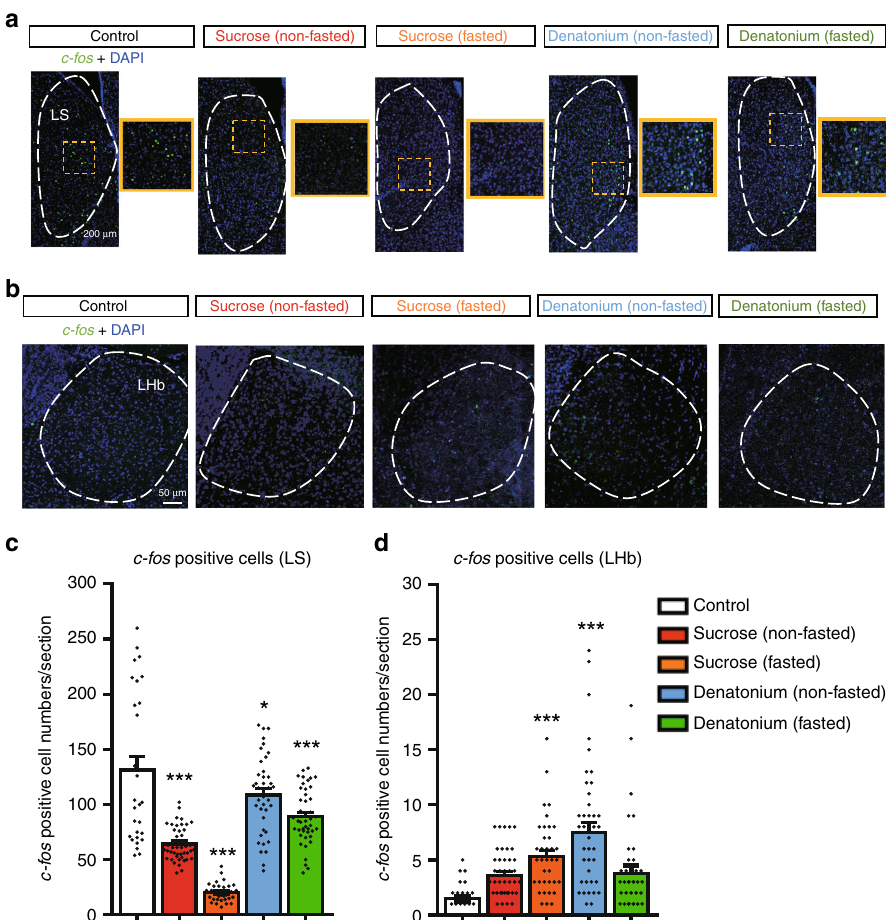
Fig. 8 Fasting differentially affects taste-induced c-fos expression in the LS and the LHb. a , b Representative images showing c-fos -positive cells in the LS ( a ) and in the LHb ( b ). c , d Quanti fi cation of c-fos- positive cells in the LS ( c ) and in the LHb ( d ). The mice were treated with sucrose or bitter taste under fed or fasted conditions. n = 3 – 5 mice per group and ~10 brain slices per mouse were analyzed. F = 51.25 and P = 4.9 × 10 – 8 in c , F = 11.1 and P = 0.0069 in d , one- way ANOVA with Dunnett ’ s post hoc test. All experiments were carried out with 10- to 16-week-old male mice. Data are given as means ± SEM. * P < 0.05, ** P < 0.01, *** P < 0.001 as compared with the control